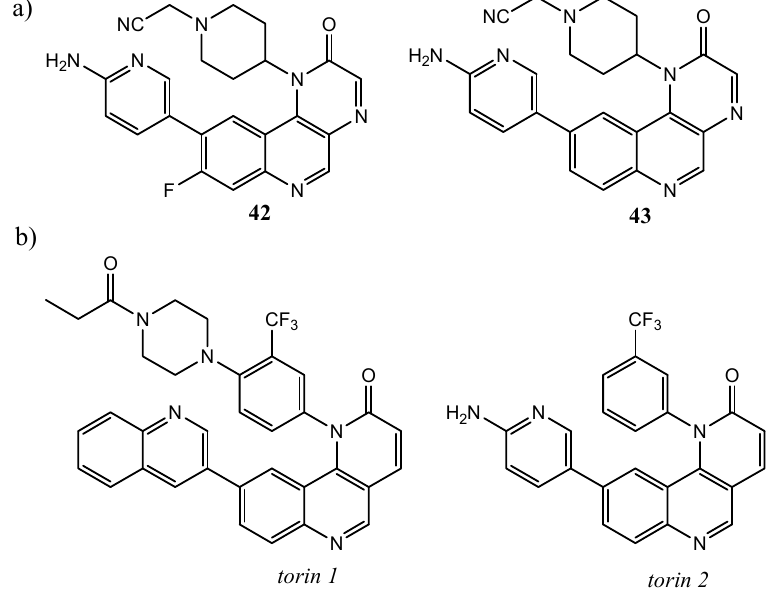
Figure 16. ( a ) mTOR inhibitors containing pyrazino[2,3- c ]quinolin-2(1H)-one scaffold; ( b ) structures of torin 1 and torin 2 , mTOR inhibitors containing benzo[ h ]-1,6-naphthyridin-2(1H)-one scaffold [105– 107].